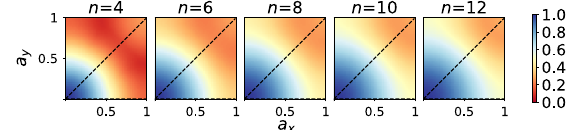
FIG. 23. j λ 2 j of configurations p ¼ 1 for different values of parameters a